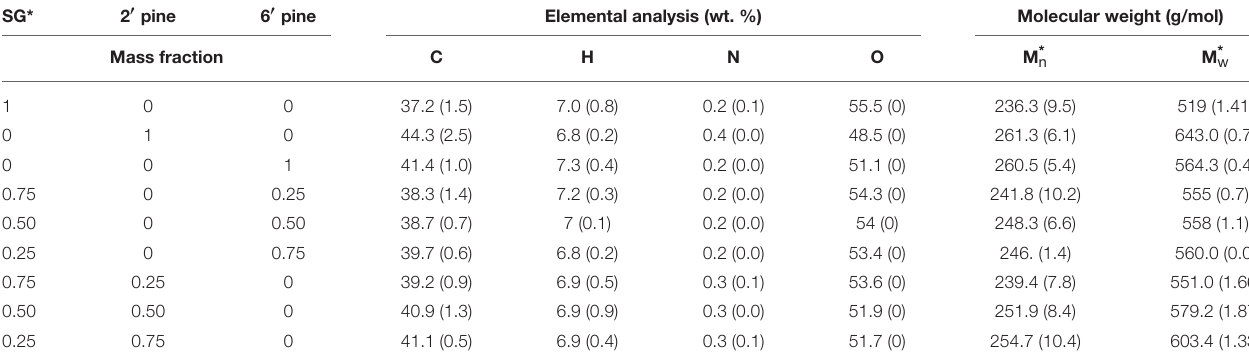
TABLE 6 | Elemental analysis and molecular weight of bio-oils produced from pure and blended switchgrass and pine residues feedstocks. SG* 2 ′ pine 6 ′ pine Elemental analysis (wt. %) Molecular weight (g/mol)